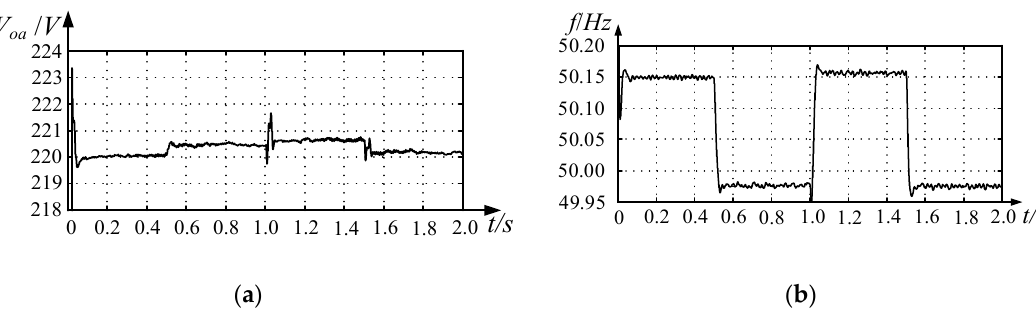
Figure 13. System voltage and frequency: ( a ) system voltage; ( b ) system frequency.